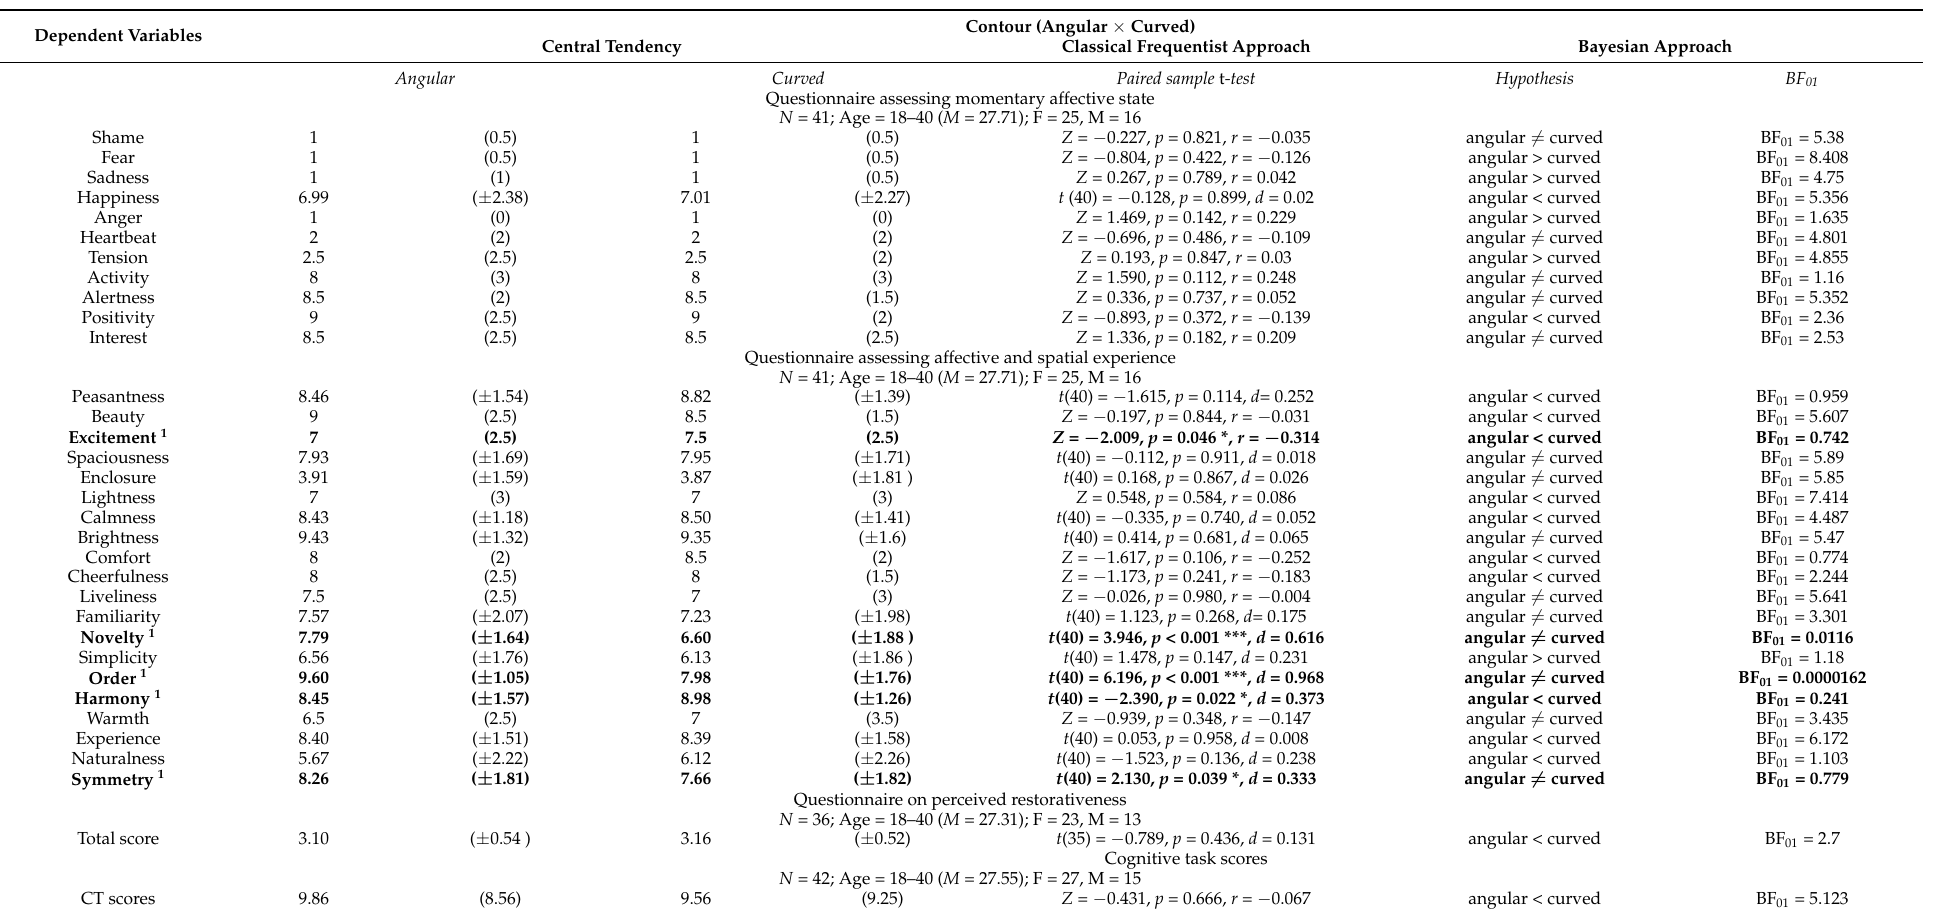
Table 1. Results of the statistical analyses performed on contour conditions using a classical frequentist approach and a Bayesian approach, in addition to the central tendency. Where data is normally distributed, means with standard deviation, and Student t -test results are reported. In the case of unmet normality assumption, we report median and IQR, and Wilcoxon signed-rank test results. Effect sizes and alternative hypotheses are also shown for each of the outcome